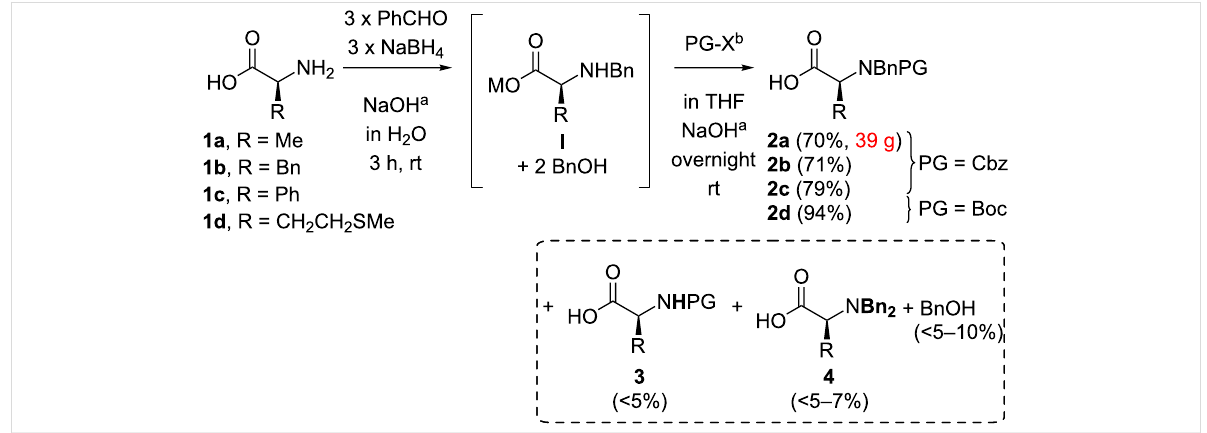
Scheme 1: Synthesis of the protected amino acids 2 . (a) KOH for 1b . b) PG–X = Cbz–Cl ( 1a–c ), Boc 2 O ( 1d